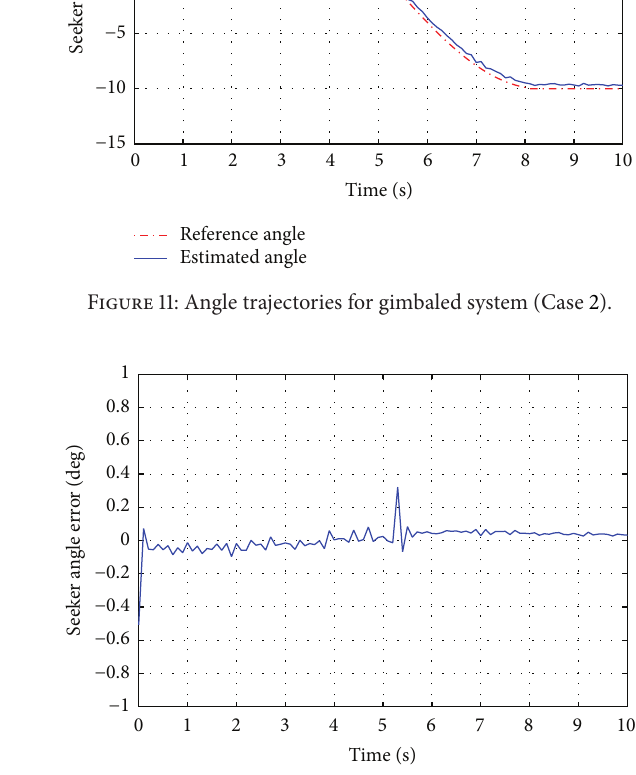
Figure 12: Error for gimbaled system (Case